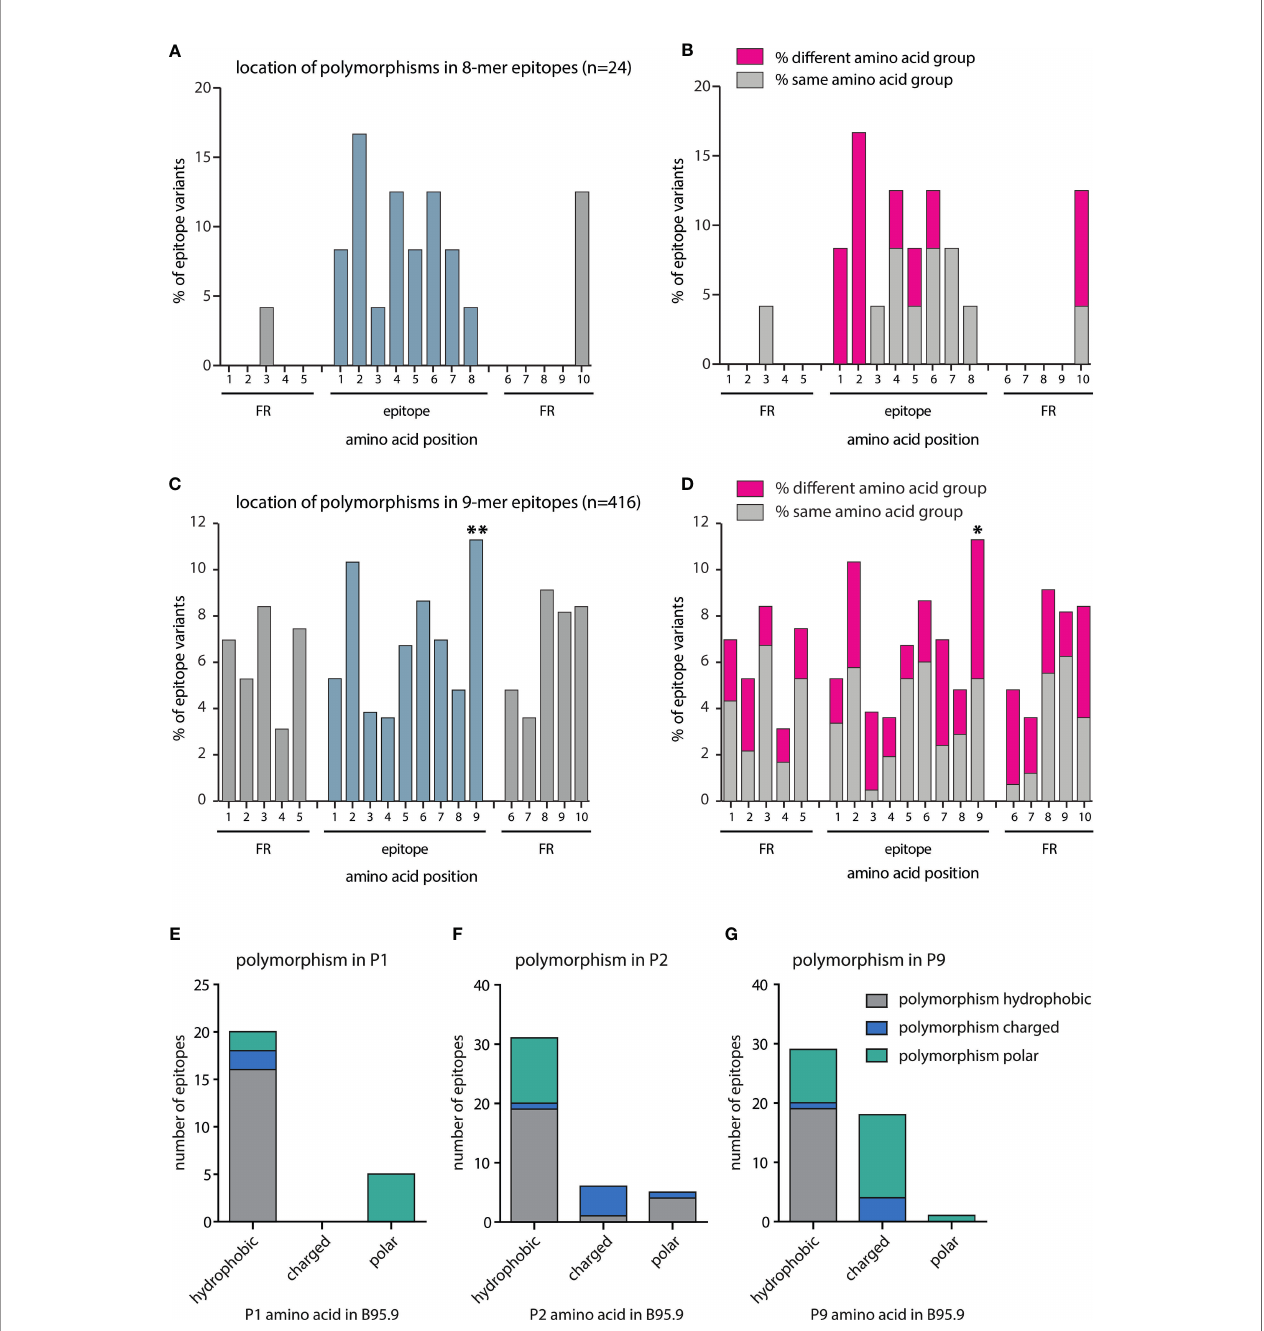
FIGURE 3 | Quantitative and qualitative analysis of amino acid exchanges in CD8+ T-cell epitopes and epitope fl anking regions. All polymorphisms in octamer and nonamer CD8+ T-cell epitopes and their fl anking regions were included in this analysis. The number of polymorphisms was determined separately for each amino acid position in all variants. Depicted are the frequencies of polymorphisms for each amino acid position in (A) octamers plus fl anking regions (n=24), and (C) nonamers plus fl anking regions (n=416). Chi 2 -test goodness of fi t test for uniform distribution was performed using MATLAB: (A) Chi 2 -value 25,45 ( p = 0.0851), (C) Chi 2 -value 71,15 ( p < 0.00001). For each position, a two-sided binomial test was performed using Bonferroni adjustment. P-values were indicated as follows * p ≤ 0.002; ** p ≤ 0.0002. (B, D) Amino acids were divided into the subgroups charged (D, E, K, R), polar (C, H, N, Q, S, T, W, Y), and hydrophobic (A, F, G, I, L, M, P, V). For each position, the percentage of polymorphisms was determined that resulted in a change of the amino acid subgroup. In nonamer epitopes, the number of hydrophobic, charged, and polar amino acids present at positions one (E) , two (F) , and nine (G) was determined and the number of amino acid exchanges resulting in the same or a different subgroup de fi